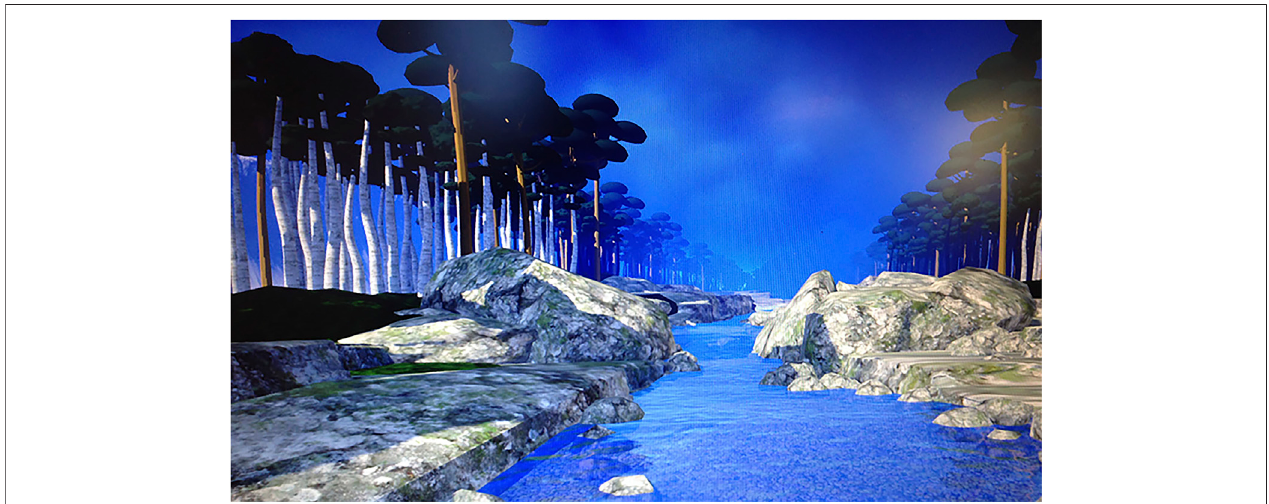
FIGURE 7 | In Mindfulness RiverWorld, patients while in a natural and calming virtual world, patients listen to instructions that teach mindfulness skills. Image by bigenvironments.com, copyright Hunter Hoffman, www.vrpain.com.